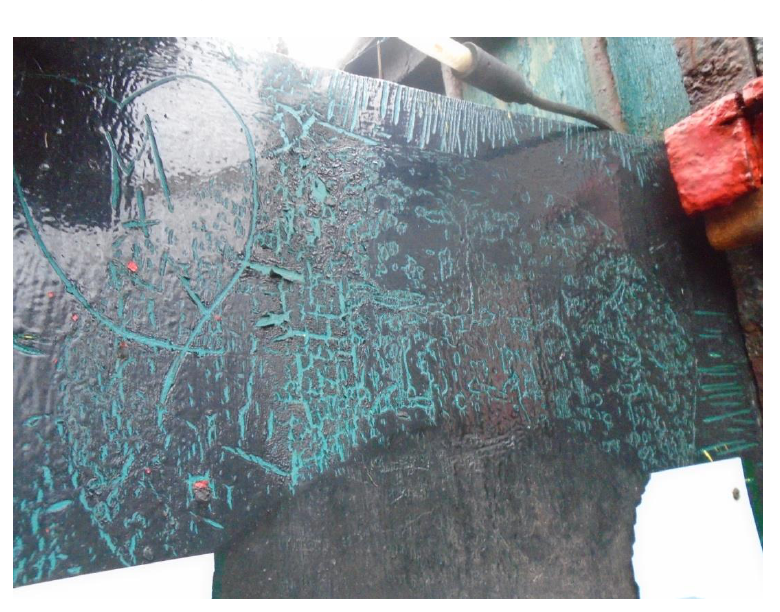
Figure 20. ( a ) Rusting table; ( b ) Shredded flag.